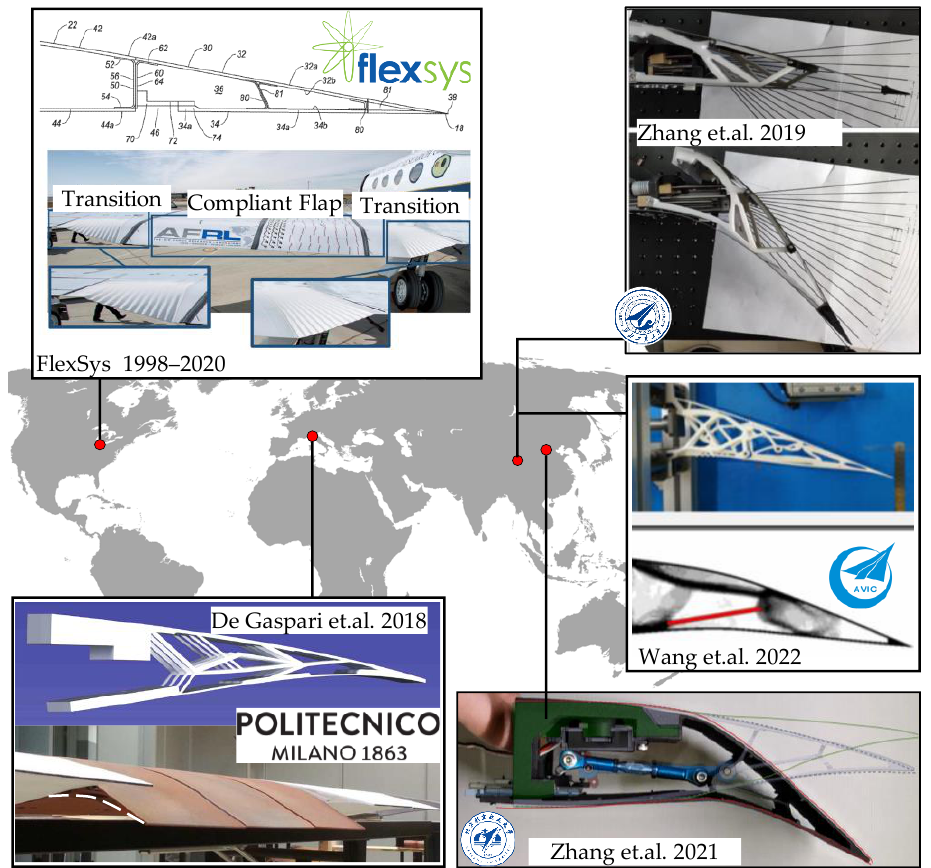
Figure 1. Trailing edge morphing solution by compliant mechanisms [1,34 – 39].